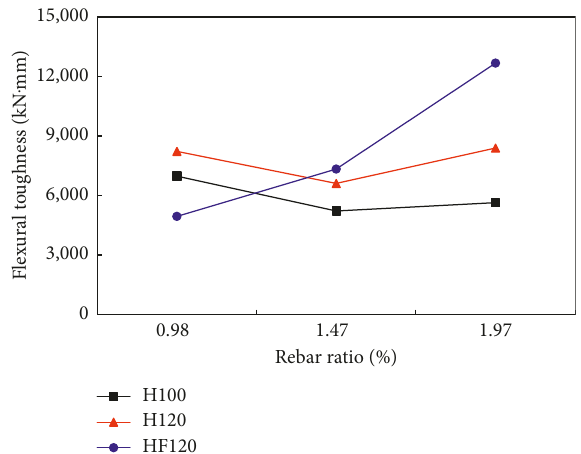
Figure 13: Comparison of the experimental results of flexural toughness for the HSFRC beams of this study and of previous studies.